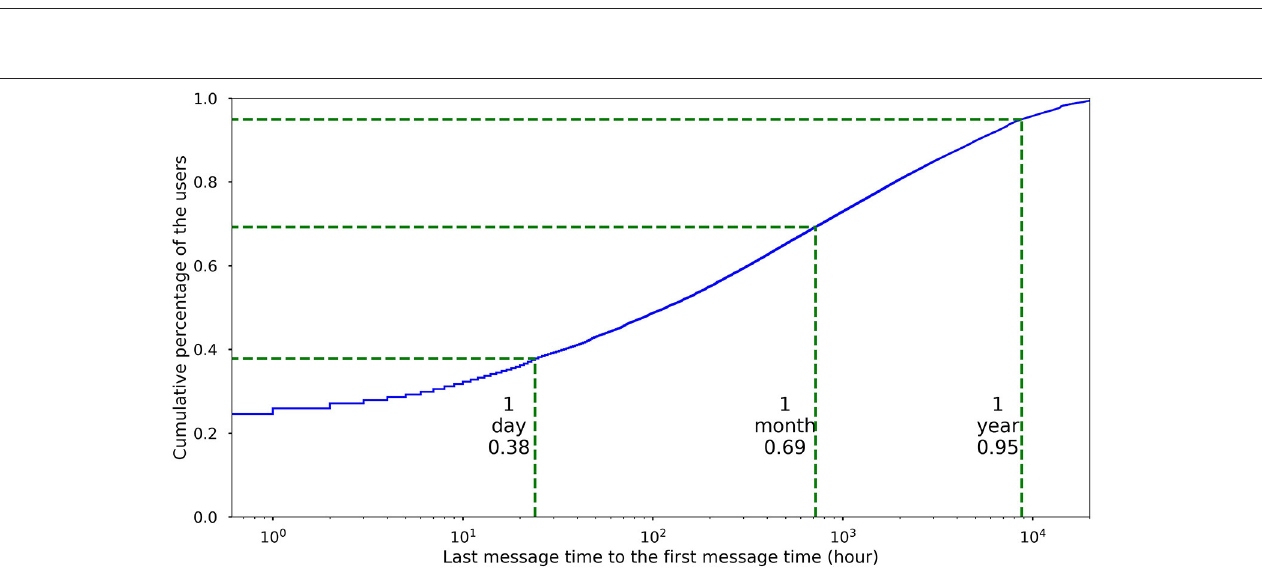
FIGURE 3 | The graph shows the cumulative percentage of users over all time who have kept the app registered on their phone measured as the time difference between the first registration message time and the last heartbeat time measured on that registered device. Thirty-eight percent uninstall within the first day of downloading, 69% within the first month, and 95% within the full year.